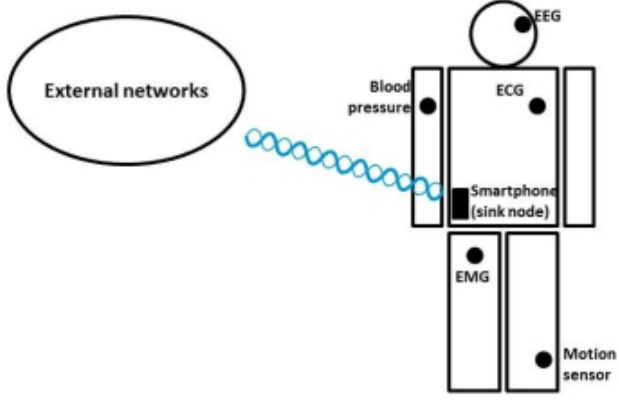
Figure 1. A general example of Wireless Body Sensor Networks